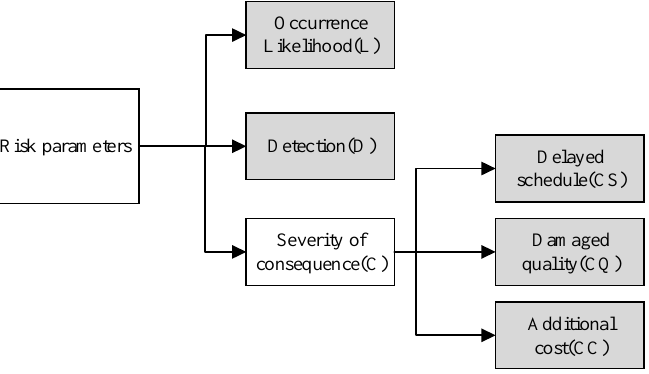
Figure 4. The hierarchical structure of the five risk parameters.